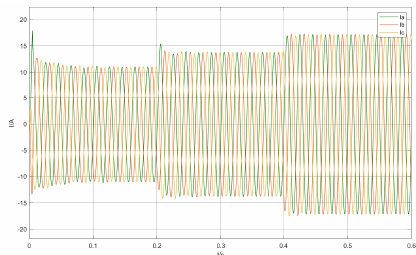
Figure 14. Output current waveform when duty cycle and modulation ratio change.